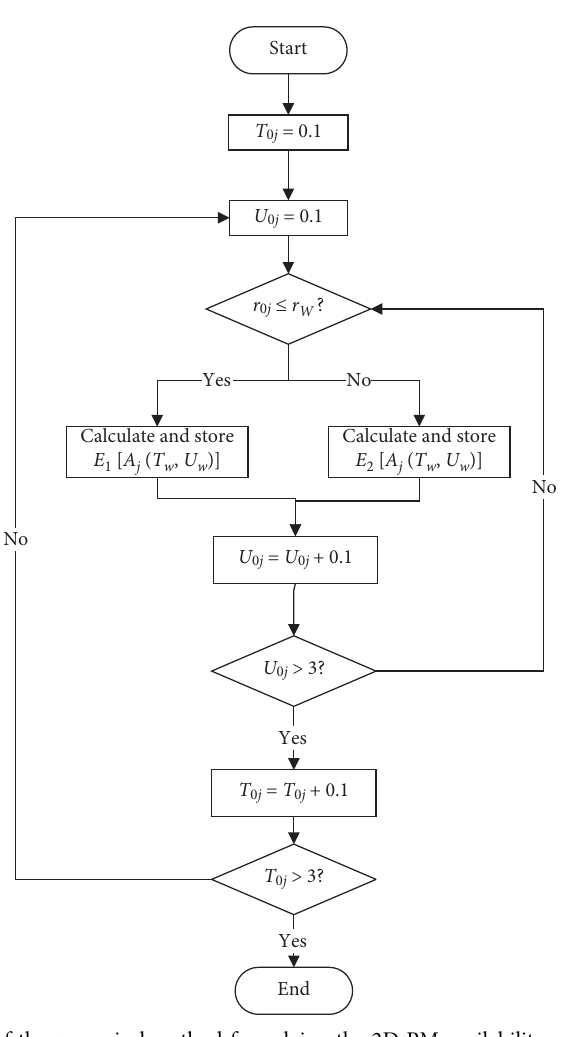
Figure 8: Flowchart of the numerical method for solving the 2D PM availability of a single component.